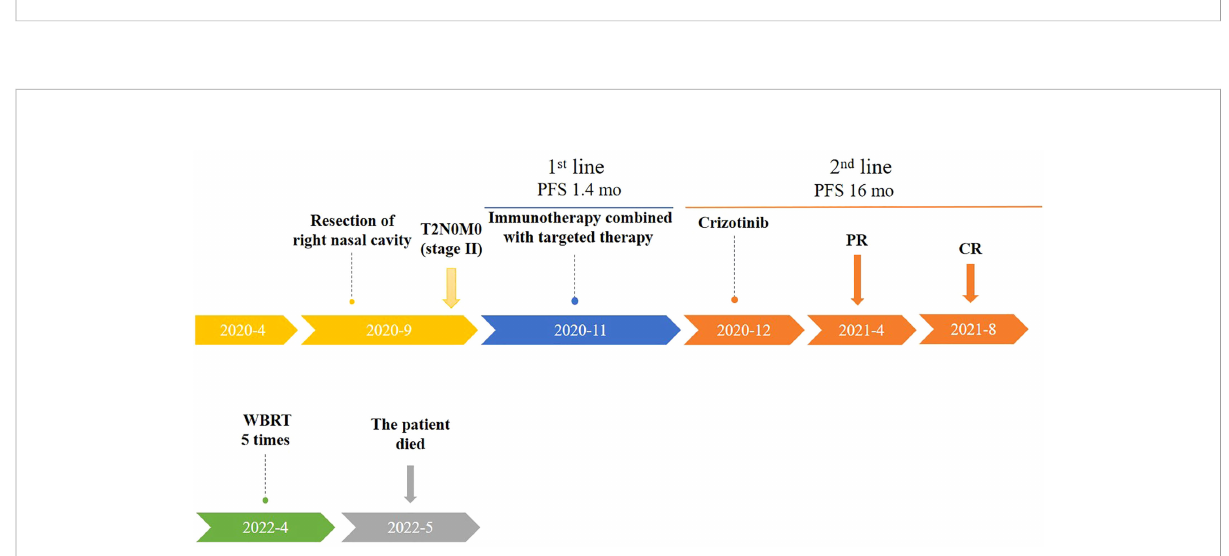
FIGURE 3 The Integrative Genomics Viewer Screenshot (A) of GOPC-ROS1 gene fusion are displayed by whole exome sequencing. The schematic diagram (B) represents the GOPC-ROS1 fusion protein domain